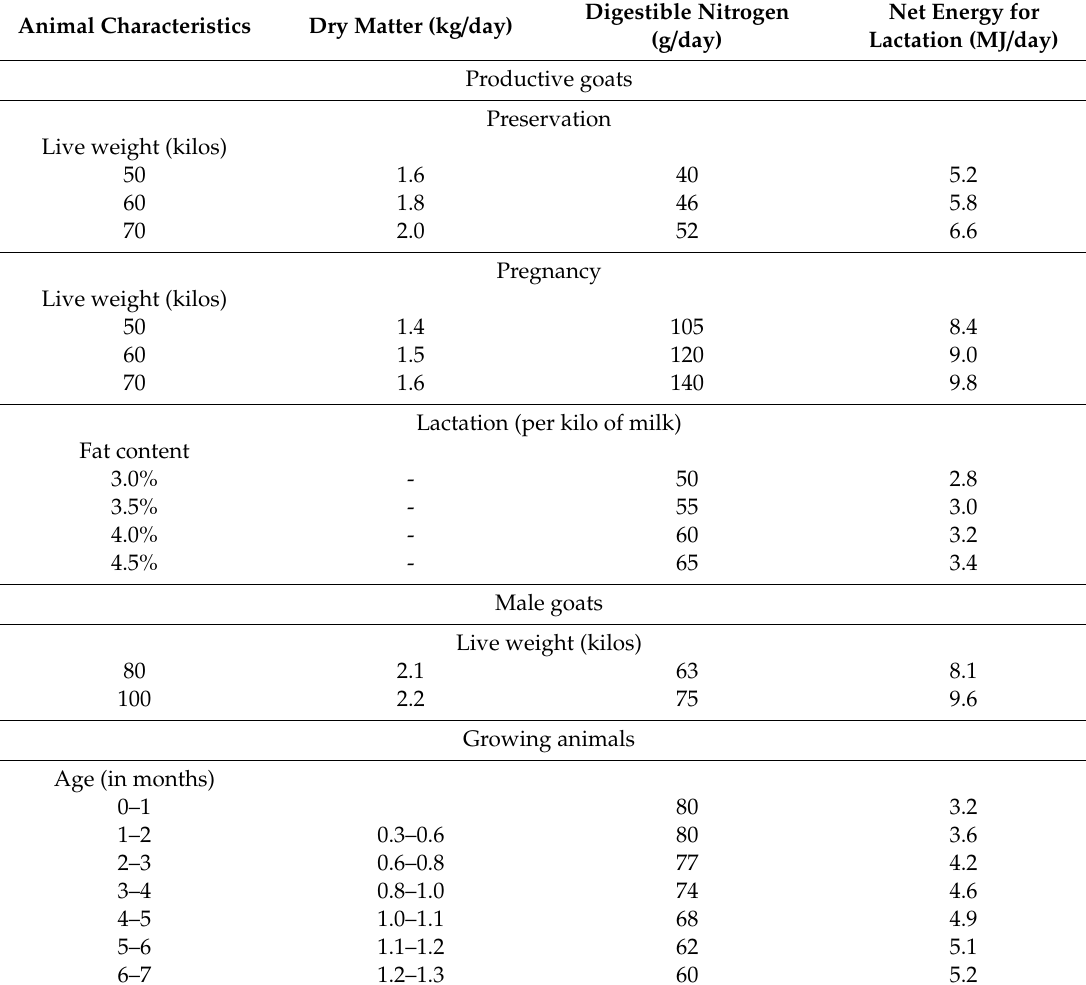
Table 1. Livestock feed